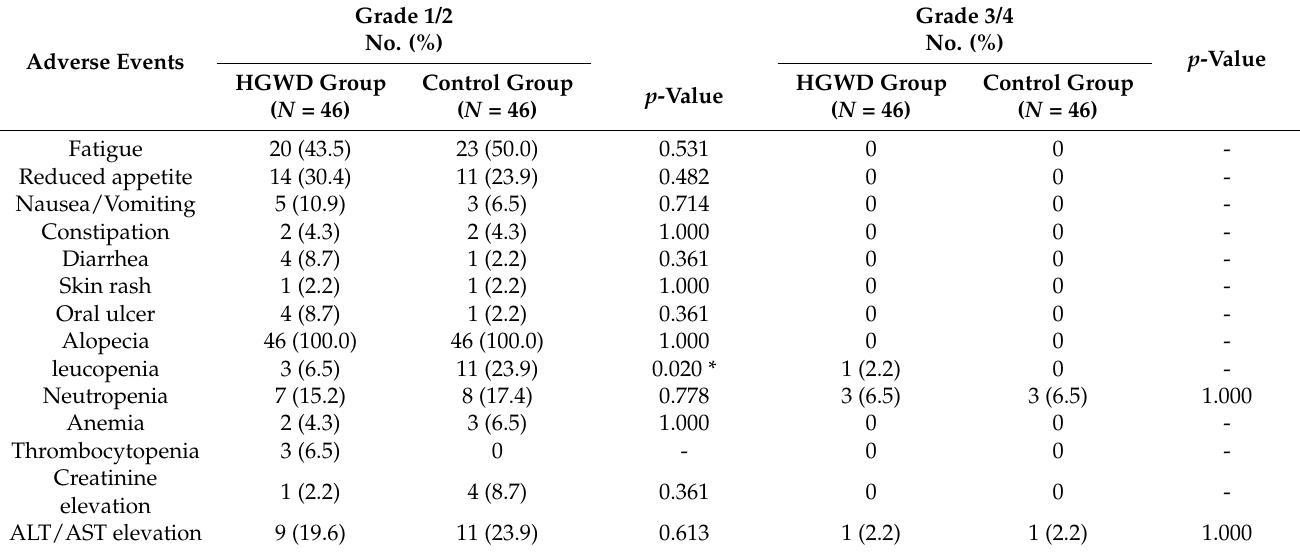
Table 3. Adverse events related to treatment.